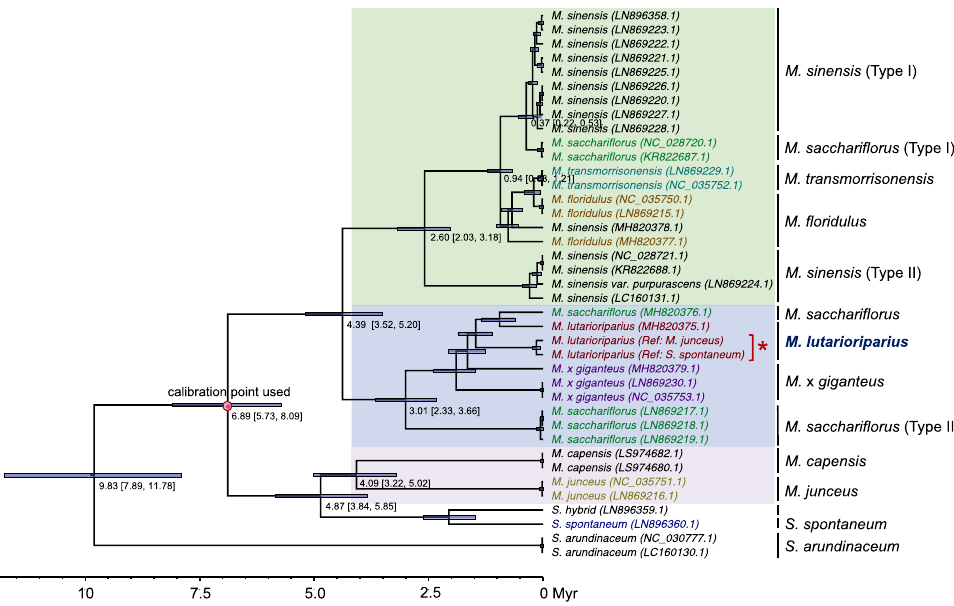
Fig. 5 Time-calibrated phylogeny analysis based on the chloroplast genomes. The calibration point was indicated using red point (data source: http:// www.timetree.org/). The light blue bars at nodes correspond to the 95% highest posterior density (HPD) of the age of the nodes. The bottom axis is in millions of years (Myr). The NCBI Reference IDs were indicated in the parentheses. Three background colors were used to indicate distinct groups in genus Miscanthus . The red star was used to indicate the chloroplast genome assemblies of our sequencing accession, which were reconstructed directly from the Illumina paired-end reads derived from whole-genome sequencing using a baiting and iterative mapping approach, by which two references were used ( M. junceus and S. spontaneum